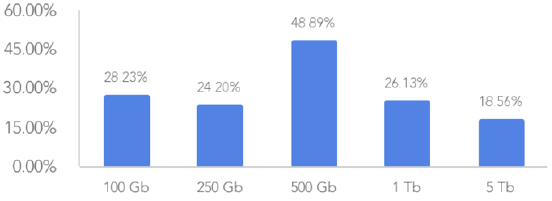
Figure 2. Cache hit rate under different cache disk